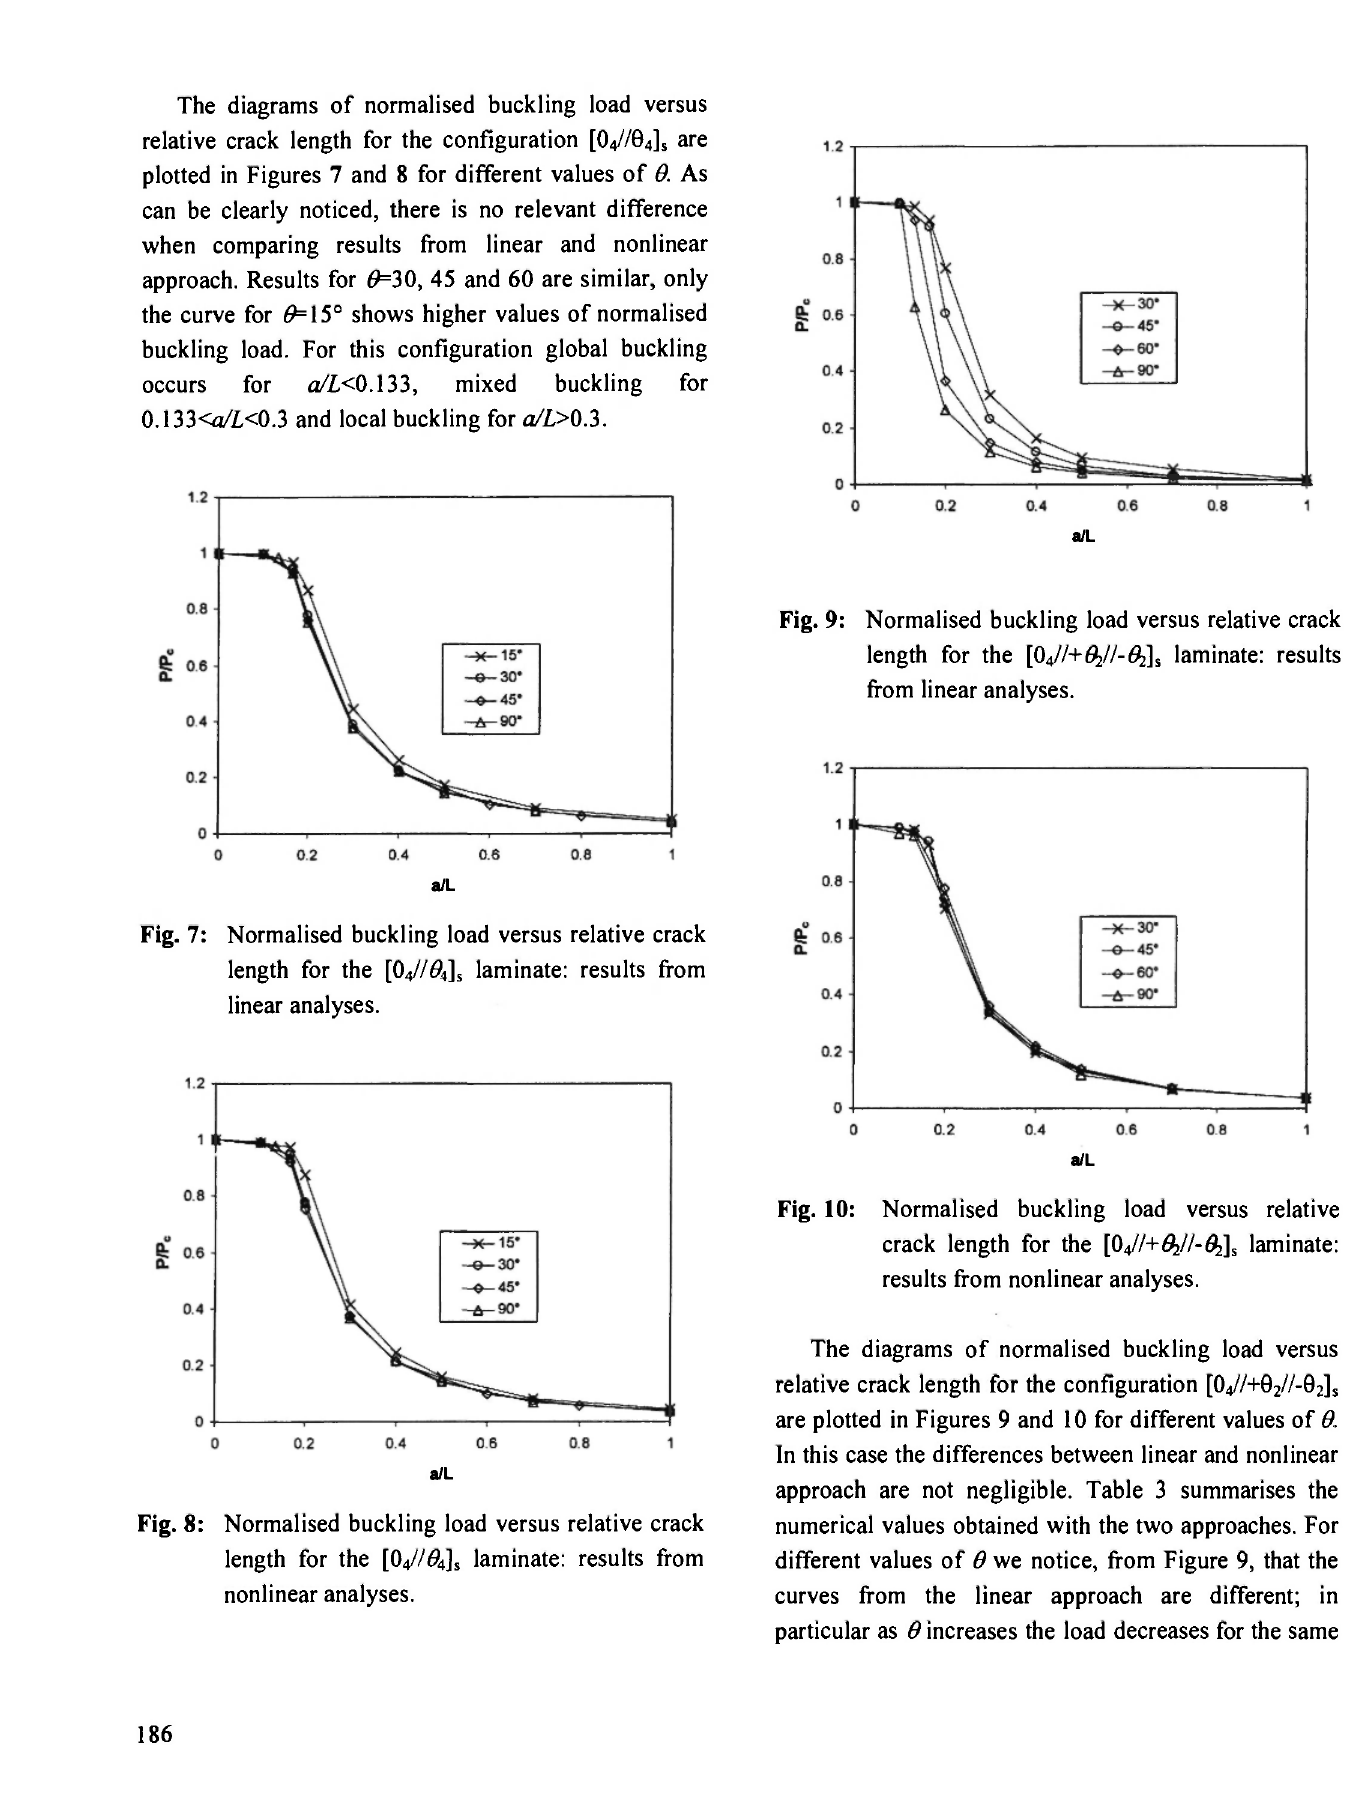
Fig. 8: Normalised buckling load versus relative crack length for the [0 4 //# 4 ] s laminate: results from nonlinear analyses.